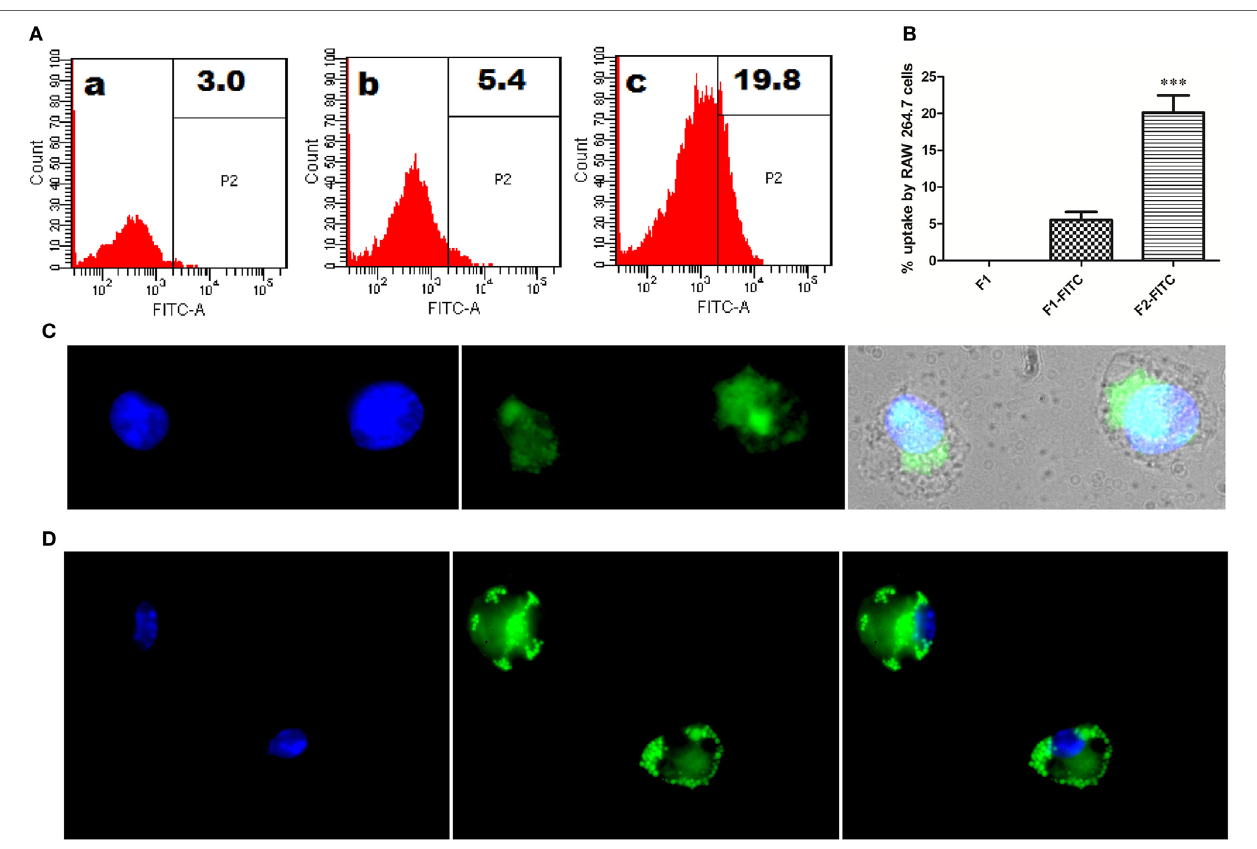
FigUre 3 | In vitro interaction between Ag85B aggregates and professional antigen presenting cells. (a) Uptake of aggregated Ag85B by RAW264.7 macrophages as revealed by FACS analysis. Representative gated histograms depicting cumulative uptake of (a) native Ag85B only (F1); (b) FITC labeled native Ag85B-IFA complex (F1-FITC); and (c) FITC labeled Ag85B aggregates (F2-FITC). (B) Bar diagram displaying percent uptake of aggregated Ag85B by RAW264.7 cells. Quantitative data corresponding to FACS mediated uptake analysis of amyloidal Ag85B and controls. Data represent the means ± SD from three independent experiments and normalized to background fluorescence recorded in unlabeled F1 sample. (c) Fluorescence microscopy depicting uptaken aggregated antigen by APCs. RAW264.7 macrophages were incubated for 6 h with aggregated Ag85B (F2) and then stained with ThT for amyloid labeling and subsequently imaged (nuclei stained blue, while ThT labeled antigen in green; 100 × oil immersion lens was used). (D) Immuno-localization of aggregated Ag85B inside RAW264.7 macrophages. The protein aggregate-mediated cytosolic delivery of Ag85B was probed with monoclonal primary antibodies against native Ag85B and its subsequent detection with Alexa Fluor 488 tagged secondary antibody (nuclei stained blue and antigen in green, 100 × oil immersion